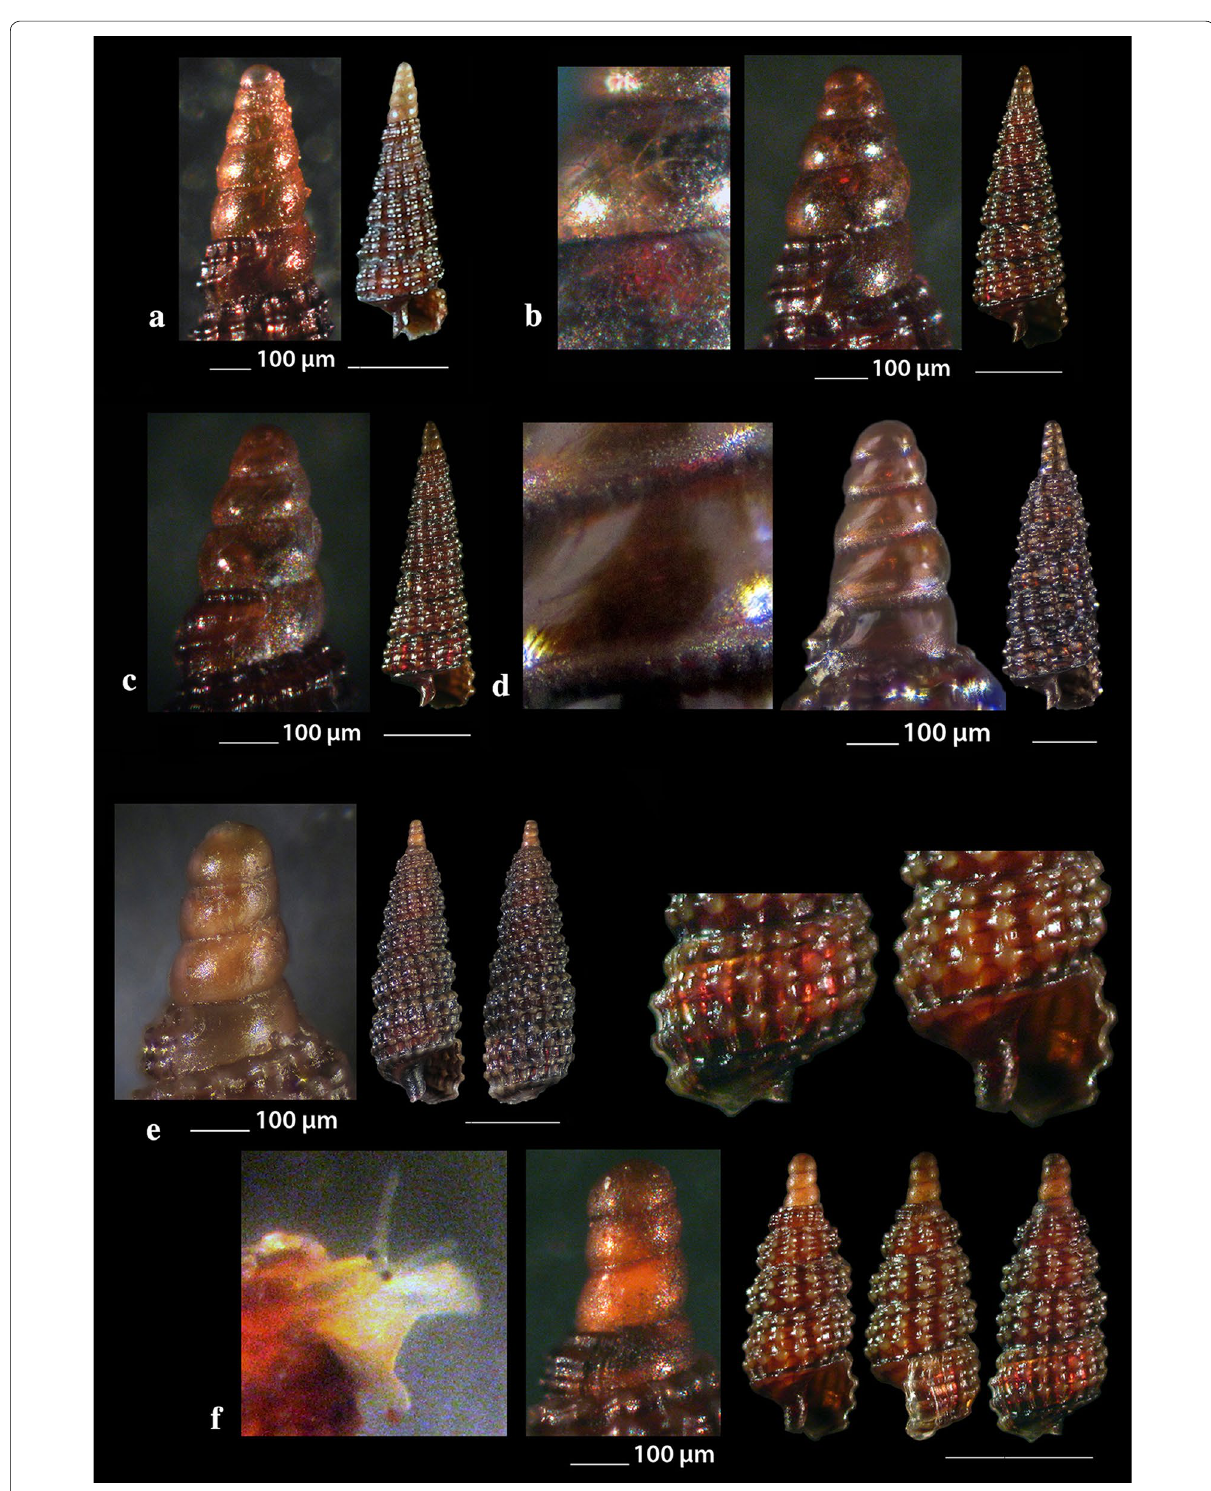
Fig. 11 a – d Cerithiopsis denticulata , e , f Cerithiopsis jeffreysi . Bar